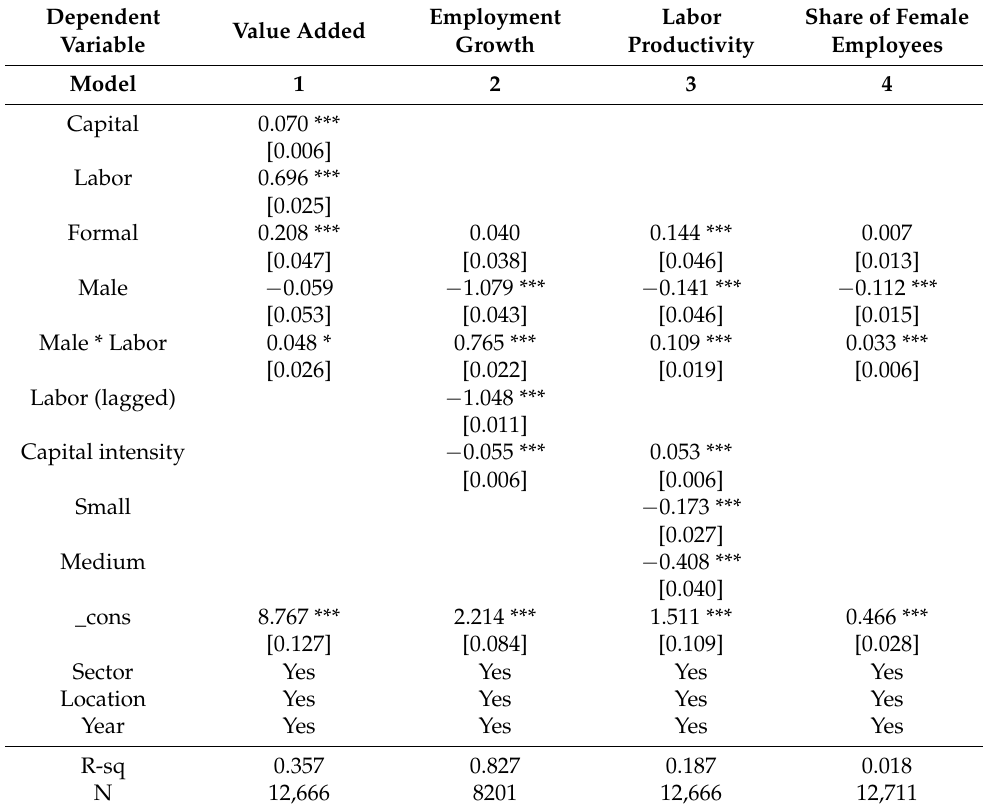
Table 8. Fixed-effects models with interaction terms between firm size and gender.